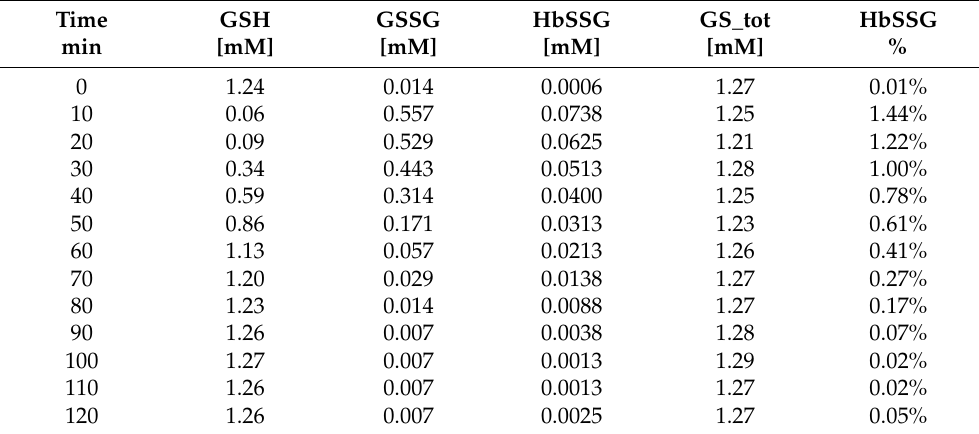
Table A1. Raw data of the experiment performed on human red blood cells by Colombo et al. [47]. These data are used to plot the graph of Figure 1 (main text) and to perform all calculations